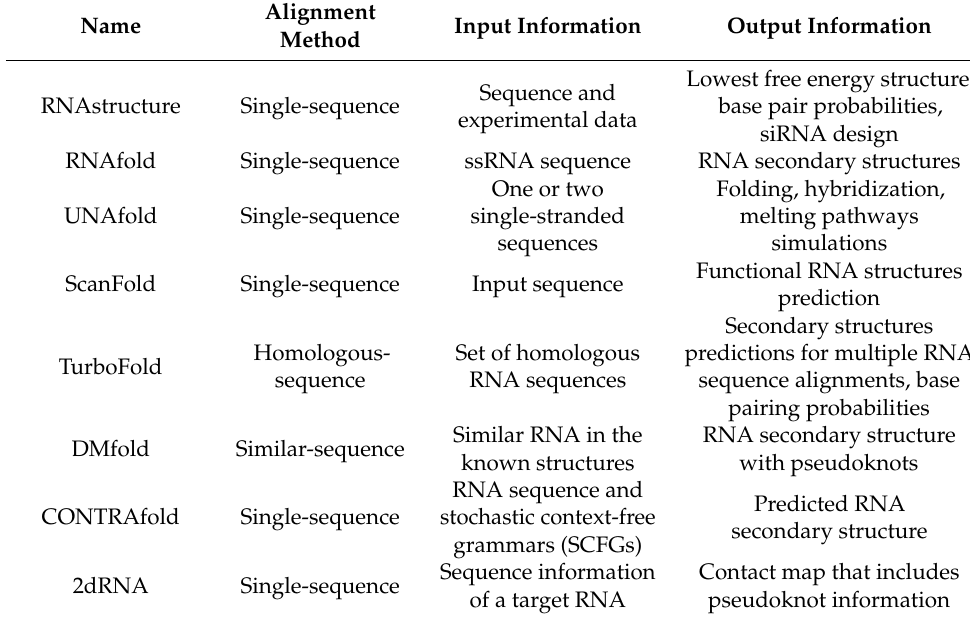
Table 1. Comparison of programs for RNA structure